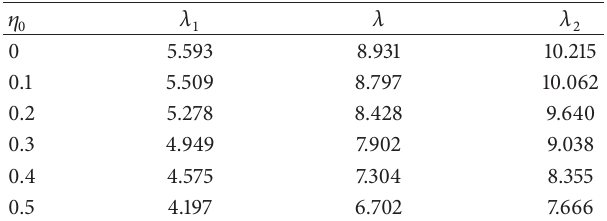
Table 6: Numerical results for clamped-sliding end DWCNTs: in columns 1 and 3, the first two dimensionless fundamental frequen- cies 𝜆 1 and 𝜆 2 , with 𝑐 12 = 0 , are reported, while in column 2, the first frequency 𝜆 , with 𝑐 12 = 0.0694 TPa, is listed.